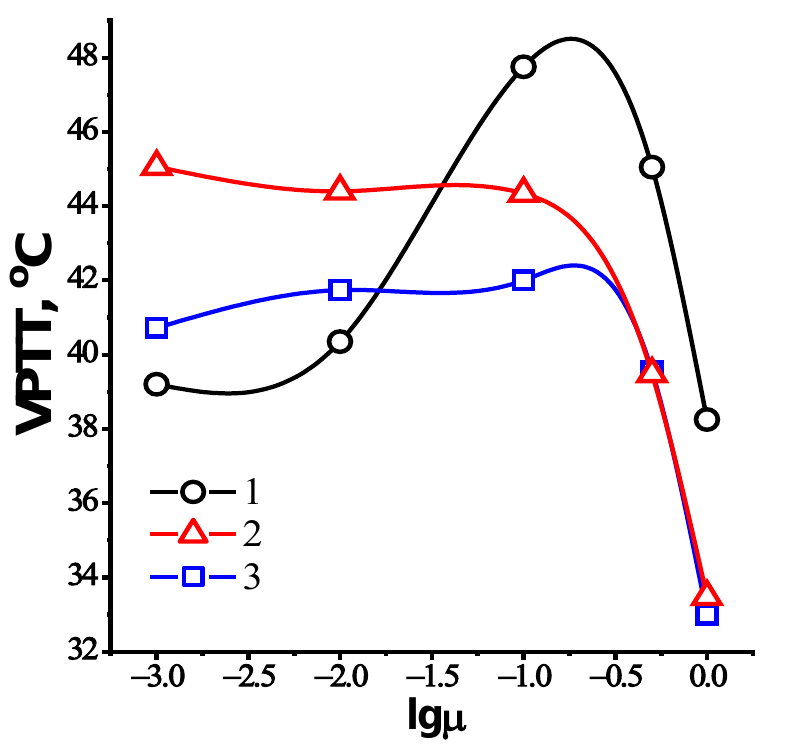
Figure 7. Temperature dependent phase behavior of nanogels based on NIPAM-APTAC-AMPS at various ionic strength ( µ ), with curves (1) NIPAM 90 -APTAC 5 -AMPS 5 ; (2) NIPAM 90 -APTAC 7.5 - AMPS 2.5 ; (3) NIPAM 90 -APTAC 2.5 -AMPS 7.5 . Table 2. The effect of ionic strength ( µ ) on the volume phase transition temperature of NIPAM- APTAC-AMPS nanogels.